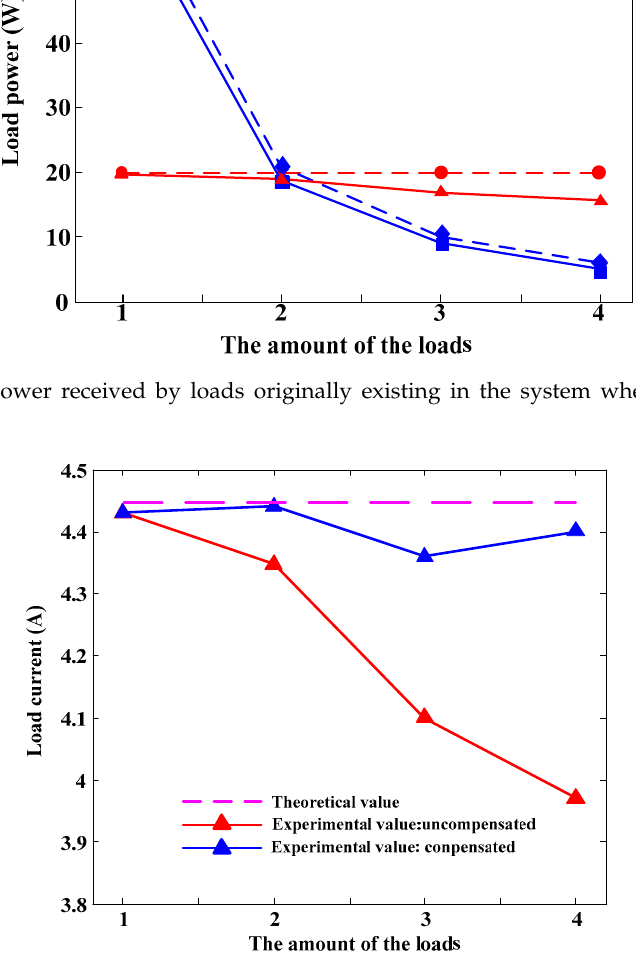
Figure 10. The power received by loads originally existing in the system when the number of loads changes.